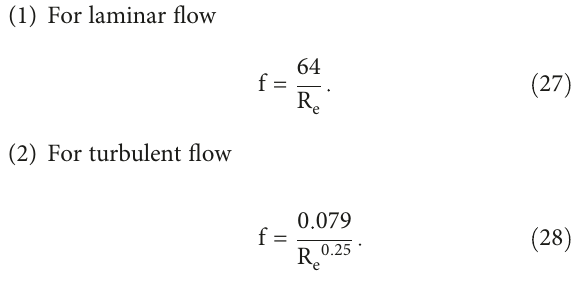
CuO/water with trapezoidal circularAl 2 O 3 /water with trapezoidal CuO/water with Al 2 O 3 /water with Figure 4: Variation of pumping power with the in fl uence of nanoparticle